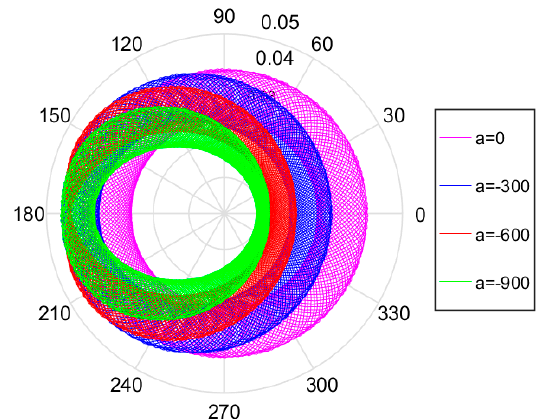
Figure 9. Polar diagram for the paths described by a point for several values of the offset of the source position from the center of the coating chamber between coordinates of (0, 0, 0) to ( − 900, 0, 0).